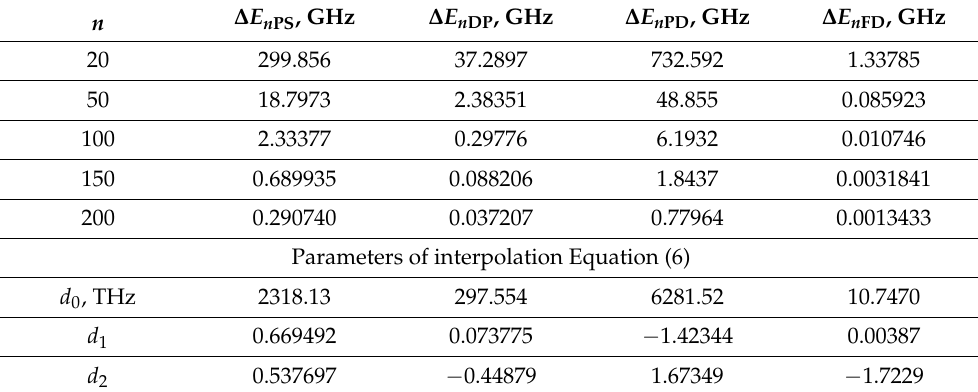
∆ E = E − E n DP n D 5/2 n P 3/2 ; from the ( n +